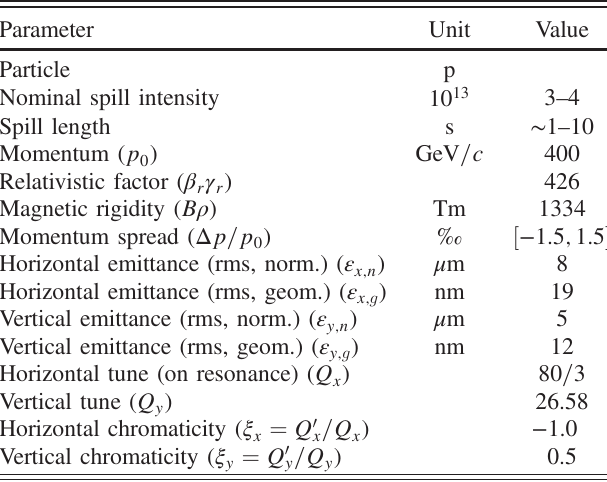
TABLE I. Machine parameters for slow extraction at SPS.